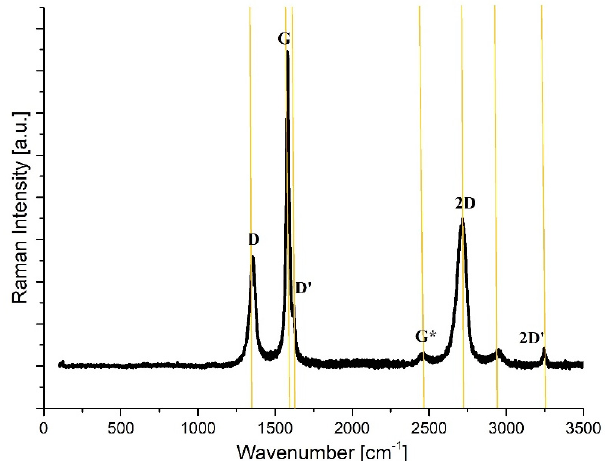
Figure -1. Raman spectra obtained for a pristine graphite sample. Figure 1. Raman spectra obtained for a pristine graphite